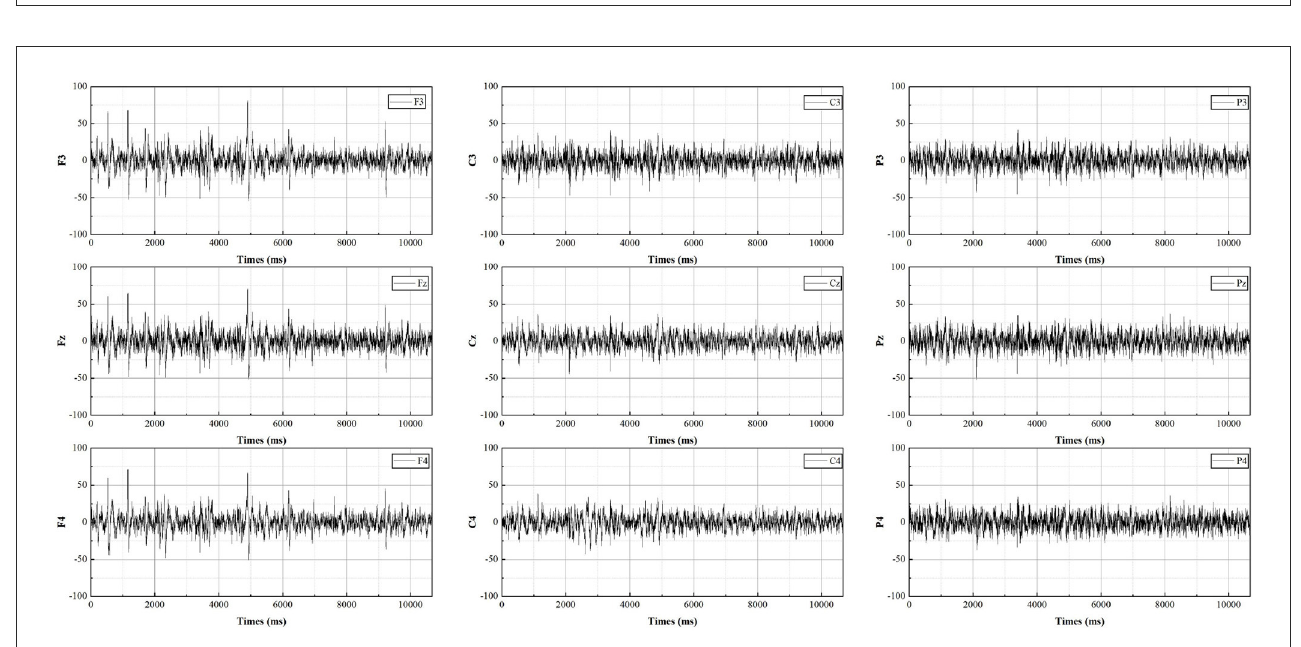
FIGURE5 The average potential value for males during horizontal swiping.